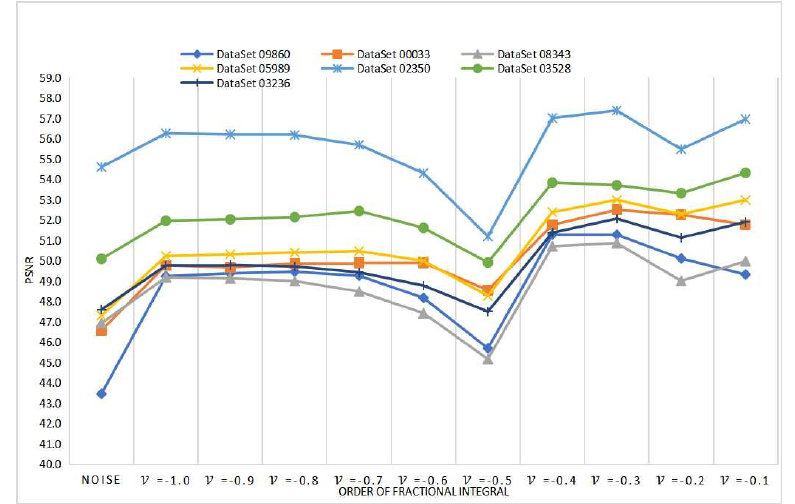
Figure 8. Optimal fractional integral filter denoising order.